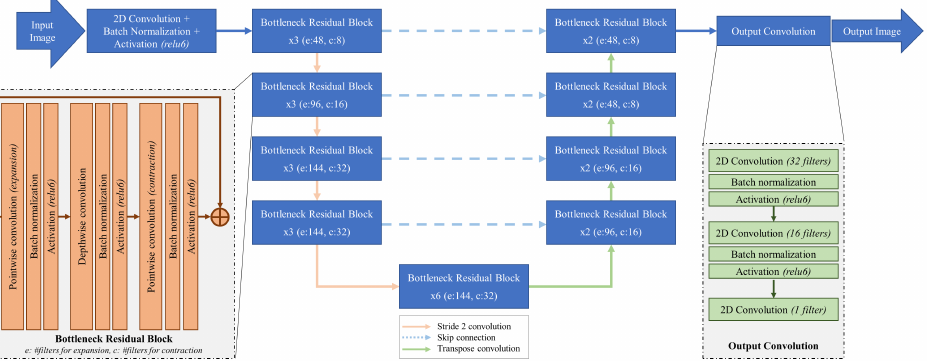
Figure 1. Mobile-PolypNet model backbone architecture with the bottleneck residual blocks and skip connection where x, e, and c in each residual block represent the number of bottleneck residual blocks in each resolution level, number of filters for expansion phase, and number of filters for the contraction phase,